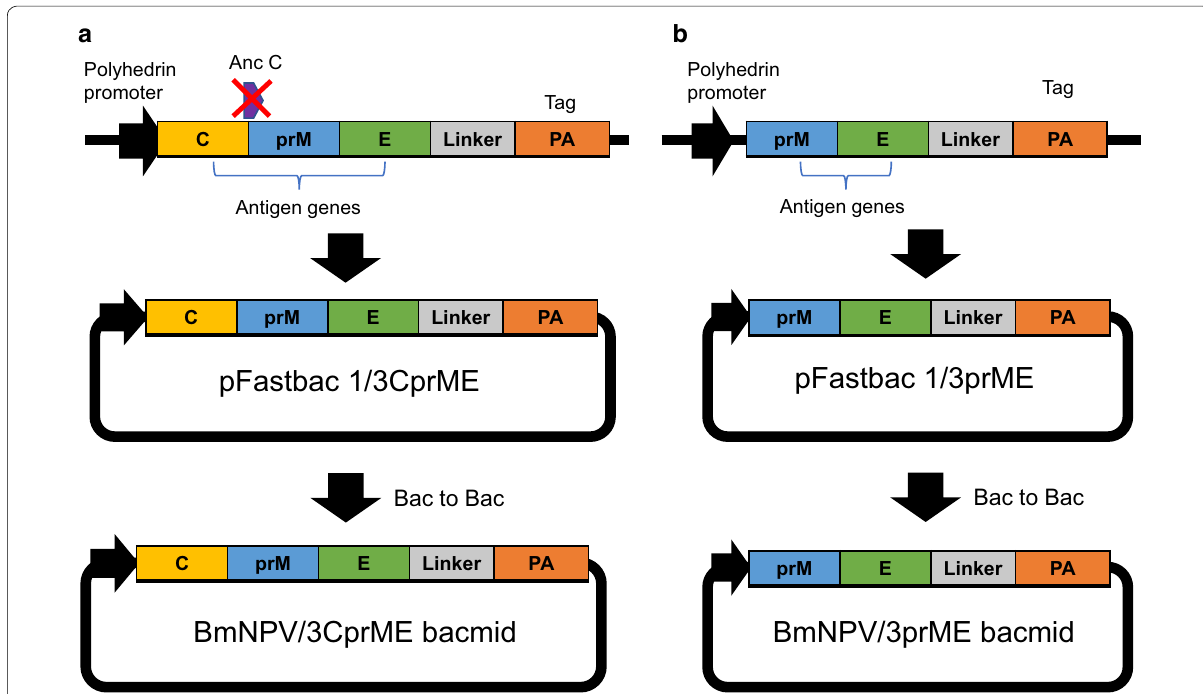
Fig. 1 Construction of recombinant dengue virus (DENV) structural proteins expressed in this study. a 3CprME with the deletion of the anchor C region and b 3prME polypeptides of DENV-3 were expressed in silkworms, pupae, and Bm5 cells as fusion proteins with a